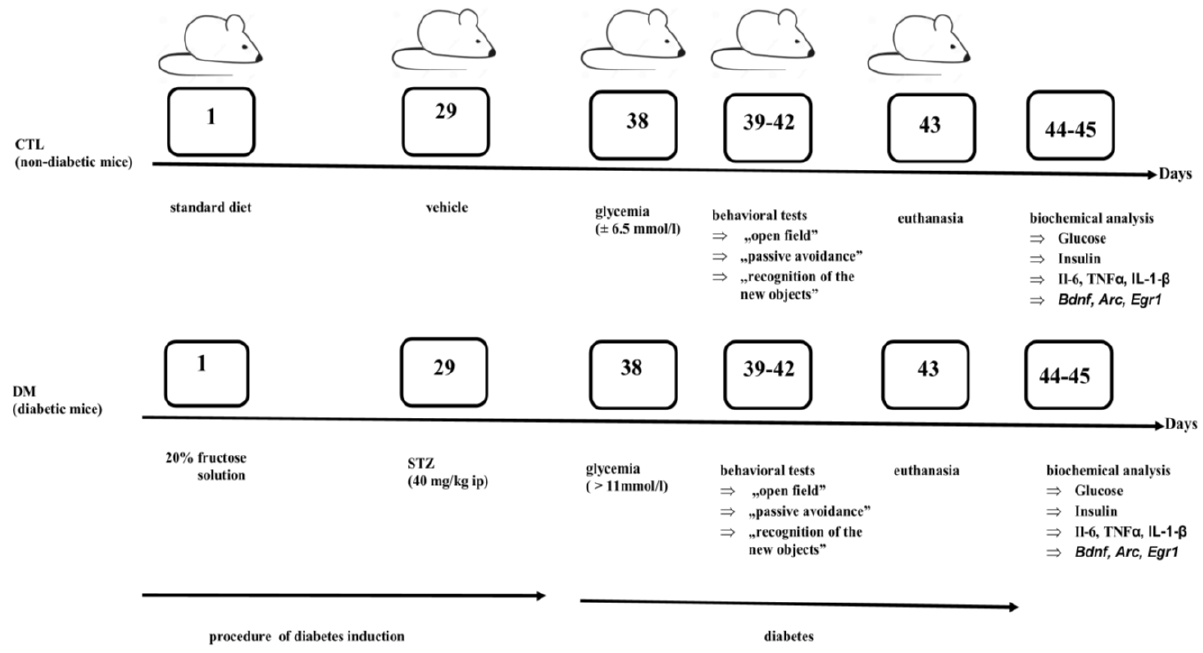
Figure 7. The experimental mouse model of type 2 diabetes mellitus (DM).